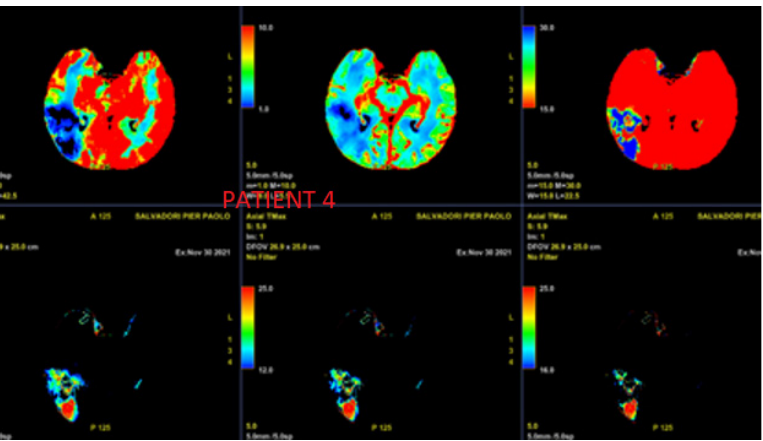
Figure 4. Vascular study of haemorragic disease in patient 4.